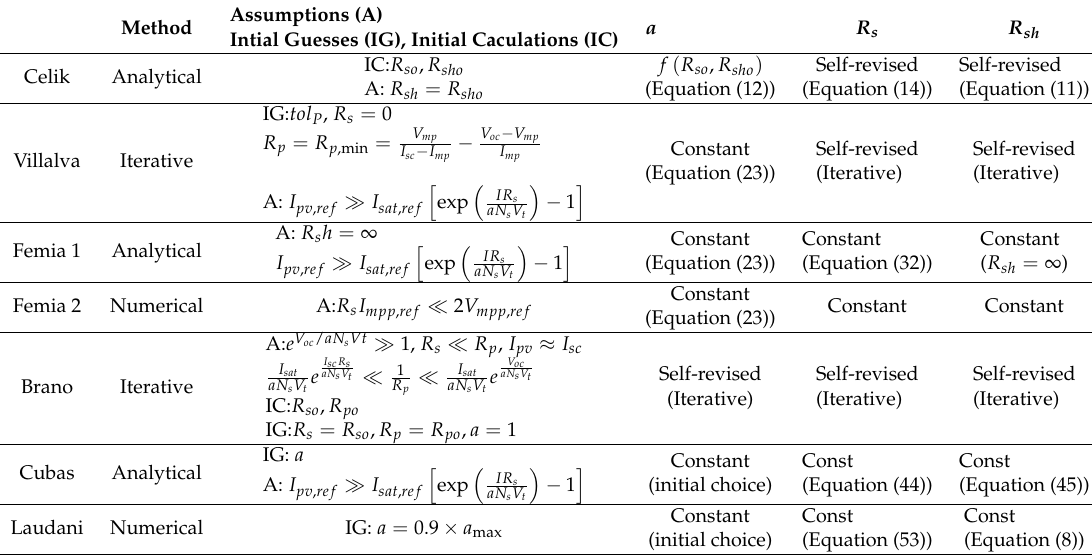
Table 1. Comparison among reviewed